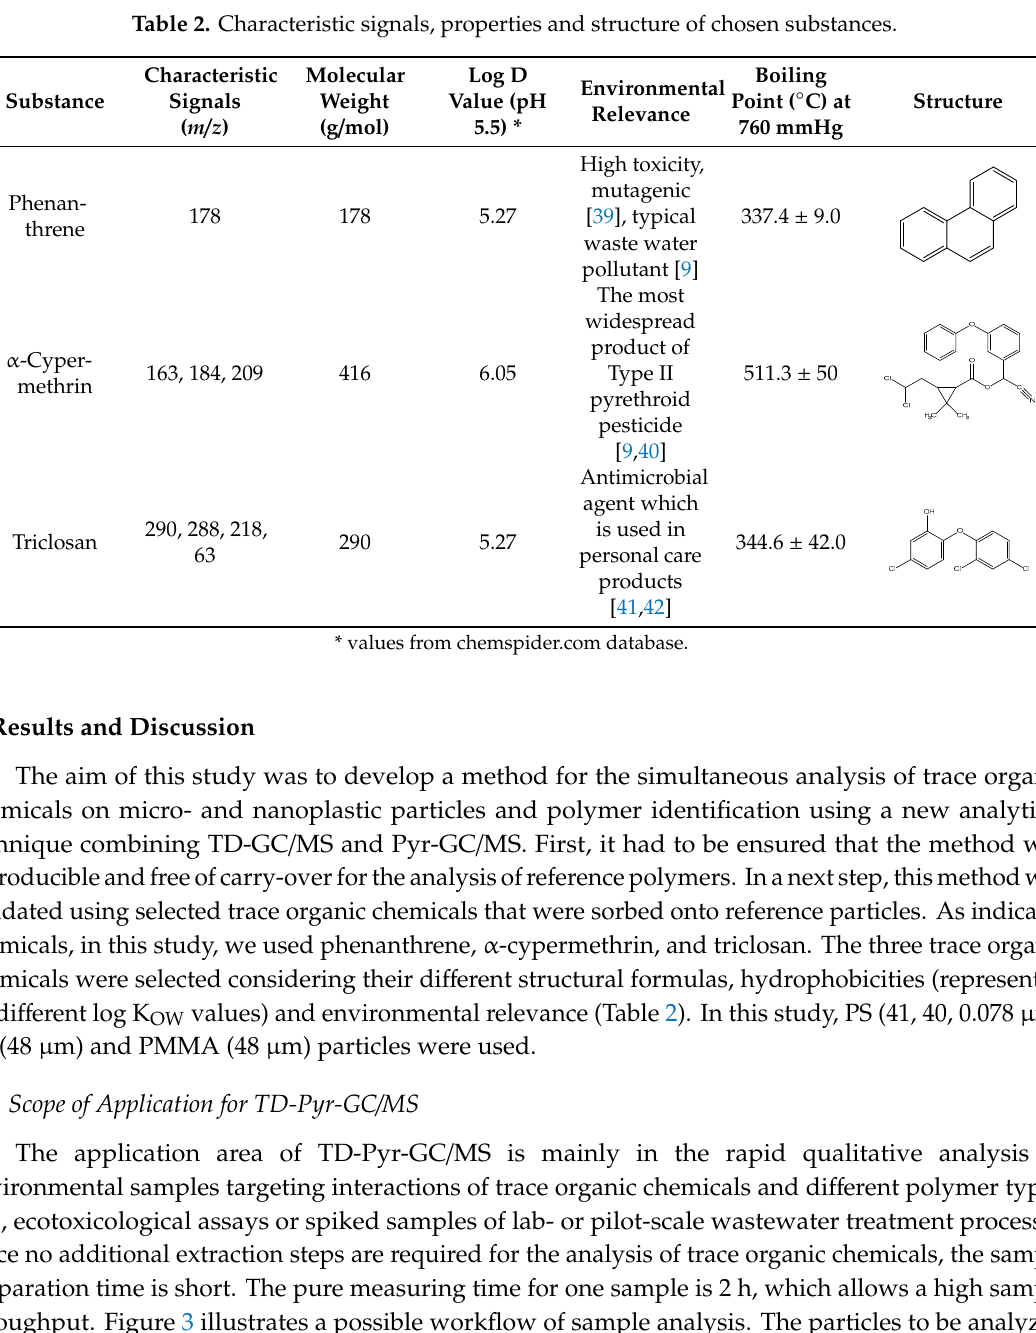
Table 2. Characteristic signals, properties and structure of chosen